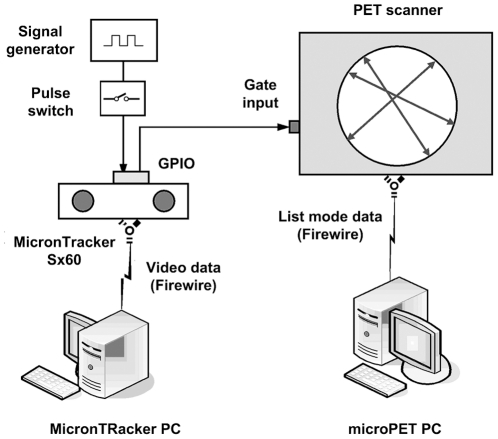
Hardware setup for synchronisation of tracker and list mode PET data.Acquisition of time-stamped stereo image frames is initiated and controlled by a signal generator triggering the tracker's external input at the desired frequency. With each frame the tracker triggers the gating input of the microPET, initiating the insertion of a data ‘tag’ in the list mode event stream.